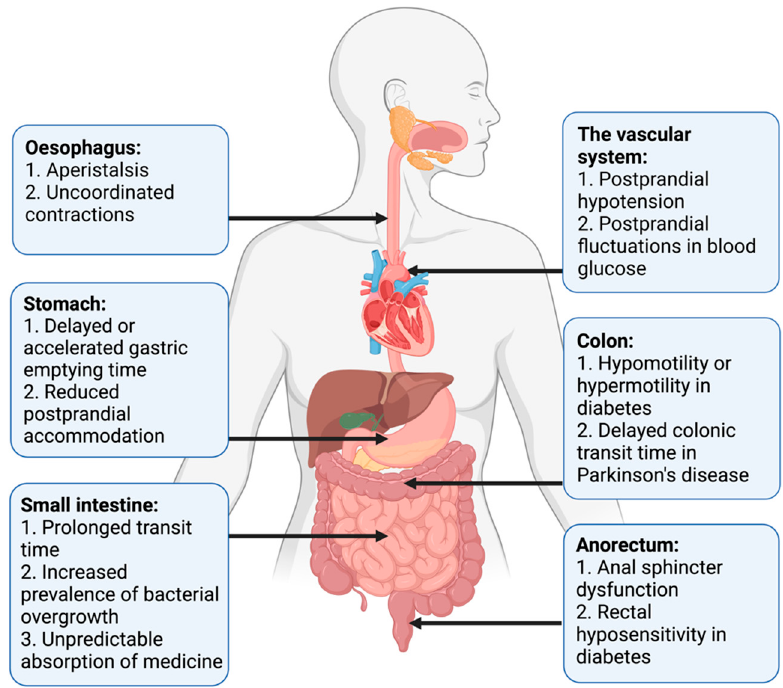
Figure 1. Motility disturbances related to autonomic dysfunction in each gastrointestinal segment.